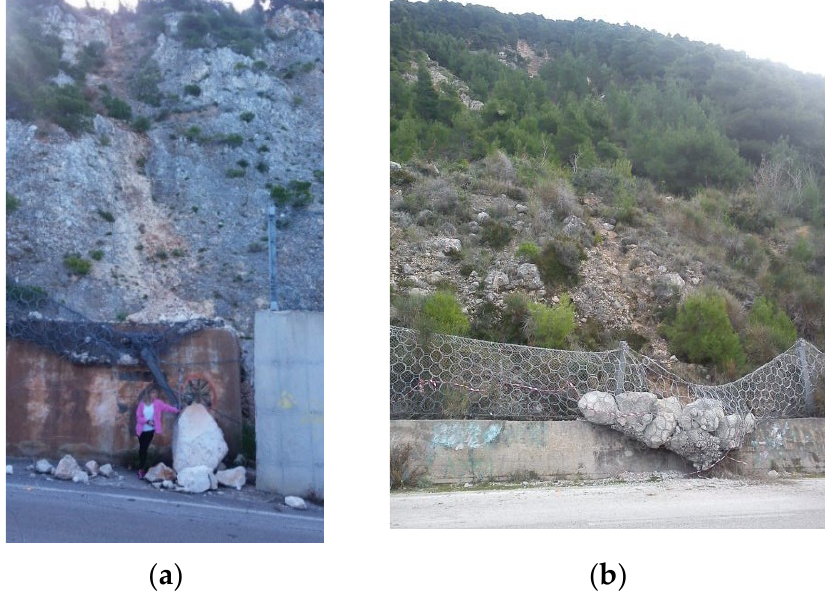
Figure 3. View of fallen rock blocks in areas A ( a ) and B ( b ) induced by the 2015 earthquake (photos taken on 19 November 2015).